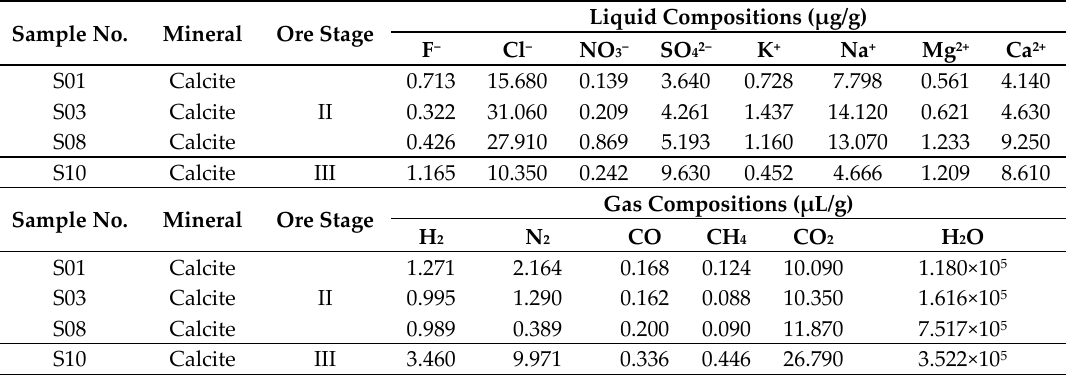
Table 2. Compositions of the fluid inclusions in ore-related calcite from Xianglushan orefield. Sample No.